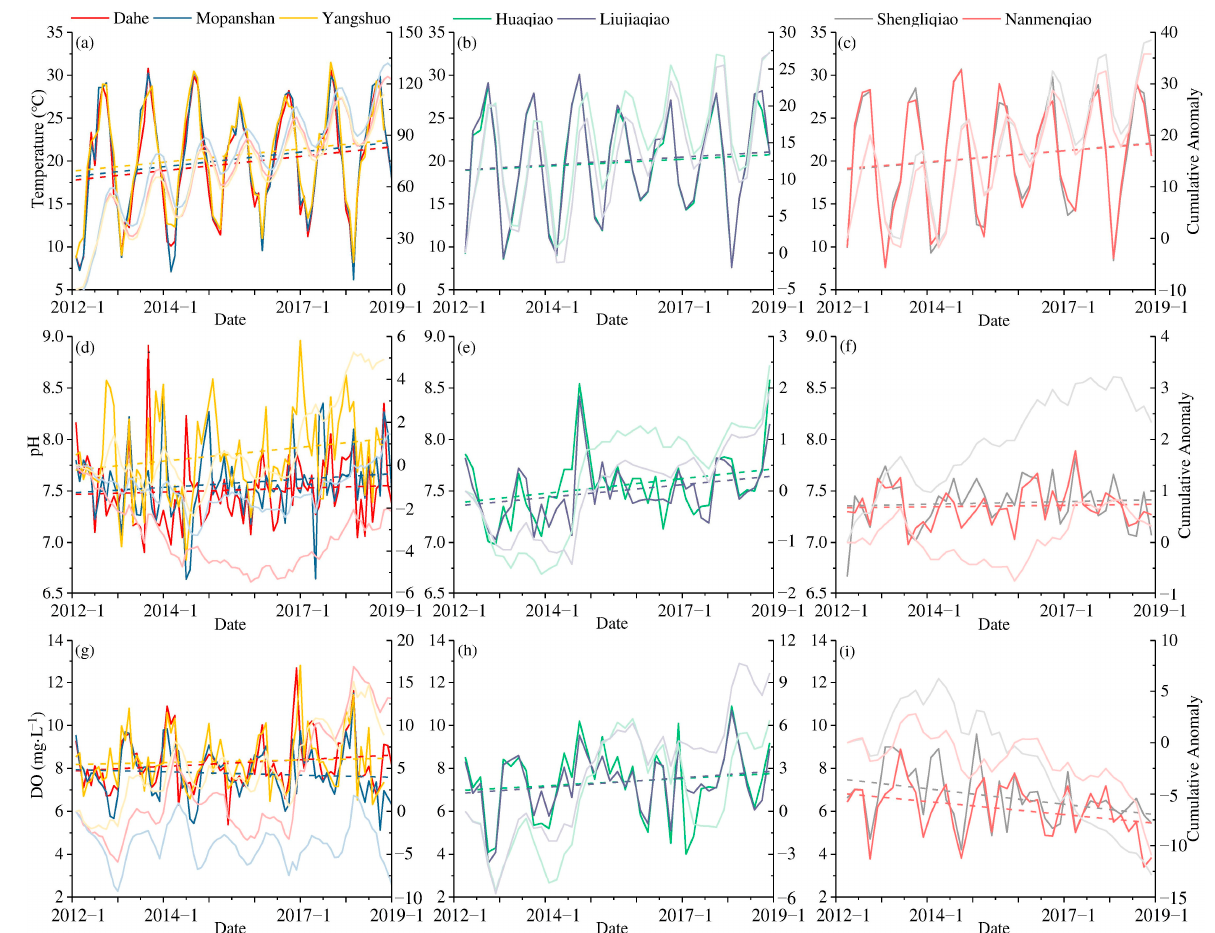
Figure 4. Changes in various environmental factors of different stations in the LRB, ( a ) Water temperature of Lijiang River, ( b ) Water temperature of Xiaodong River, ( c ) Water temperature of Taohua River, ( d ) pH of Lijiang River, ( e ) pH of Xiaodong River, ( f ) pH of Taohua River, ( g ) DO of Lijiang River, ( h ) DO of Xiaodong River, and ( i ) DO of Taohua River. The DO concentration in the Lijiang River is significantly higher than that in the tributaries, and over 75% of the DO exceeds 6.8 mg·L − 1 . The DO concentration of the Xiaodong River is slightly lower than that of the Lijiang River and is significantly higher than that of the Taohua River. Although the Xiaodong River is a tributary, both the upstream and downstream reaches connect with the Lijiang River, so the Huaqiao station upstream of the Xiaodong River also has large fluctuations. The pH values of the Xiaodong River and Dahe stations have similar growth trends, and the change rates are between 0.009 and 0.013 mg·L − 1 ·month − 1 . The Dahe and Mopanshan stations are located in the upper and lower reaches of the Guilin urban area, respectively, and demonstrate significant differences. Mopanshan’s DO demonstrated a downward trend, indicating that the water quality deteriorates to a certain extent while flowing through the Guilin urban area. As a tributary of the Lijiang River in Guilin, the Taohua River has a low water volume, a low flow rate, and a relatively low DO concentration relative to those of the mainstream. However, the DO concentration in the Taohua River continues to decrease year by year, which implies that the Taohua River carries a large amount of oxygen- consuming substances, which deteriorates the water quality of the Lijiang River to some extent. With the exception of lower-quality tributaries, the discharge of a large quantity of